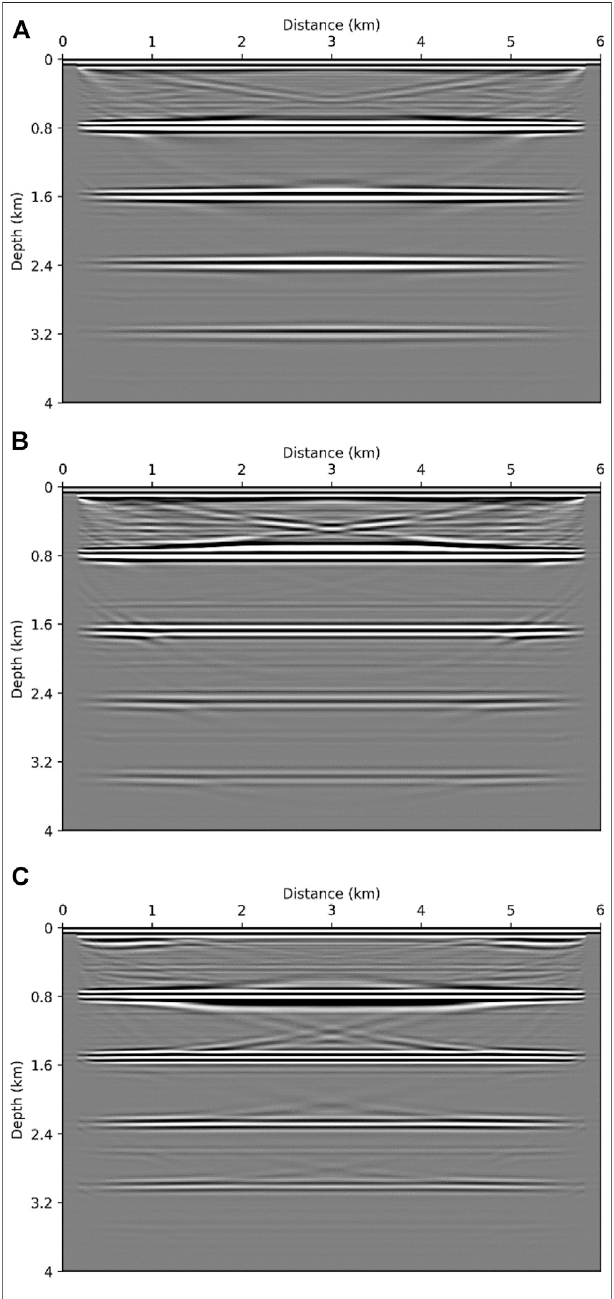
FIGURE 4| 10 FDCIGs (A) before and (B) after applying dip fi lter and 10 ODCIGs (C) before and (B) after applying dip fi lter. Note that the example of image gathers is acquired by the migration result with the smoothed true velocity